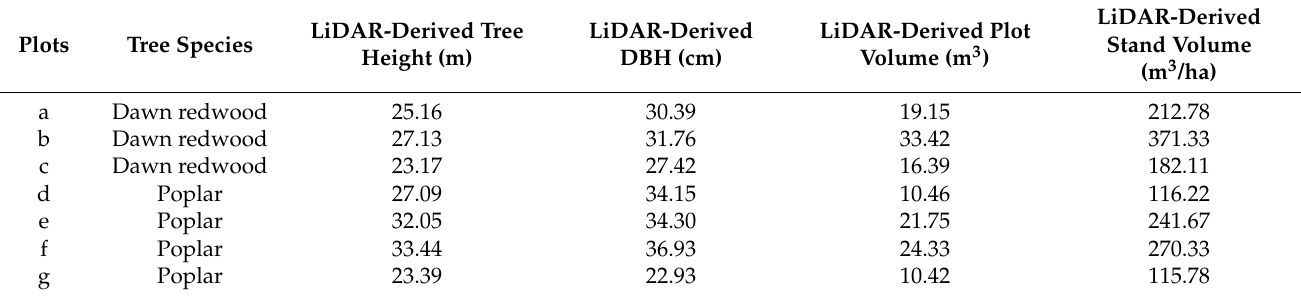
Table 9. Summary of the volumes calculated with Equation (11) and stand volumes calculated with Equation (12) by plot.